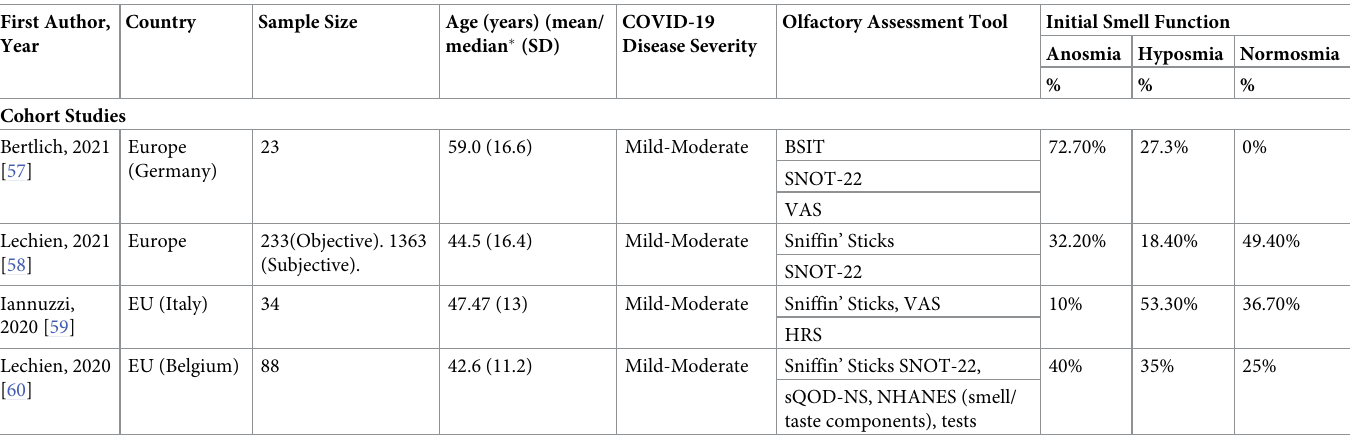
Table 3. Study characteristics of studies that used objective and subjective olfactory